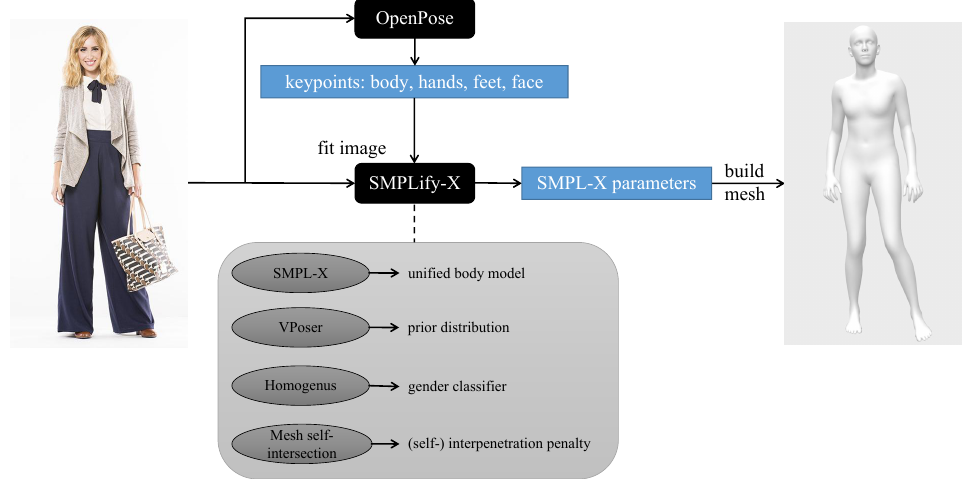
Figure 5. The image-fitting process of